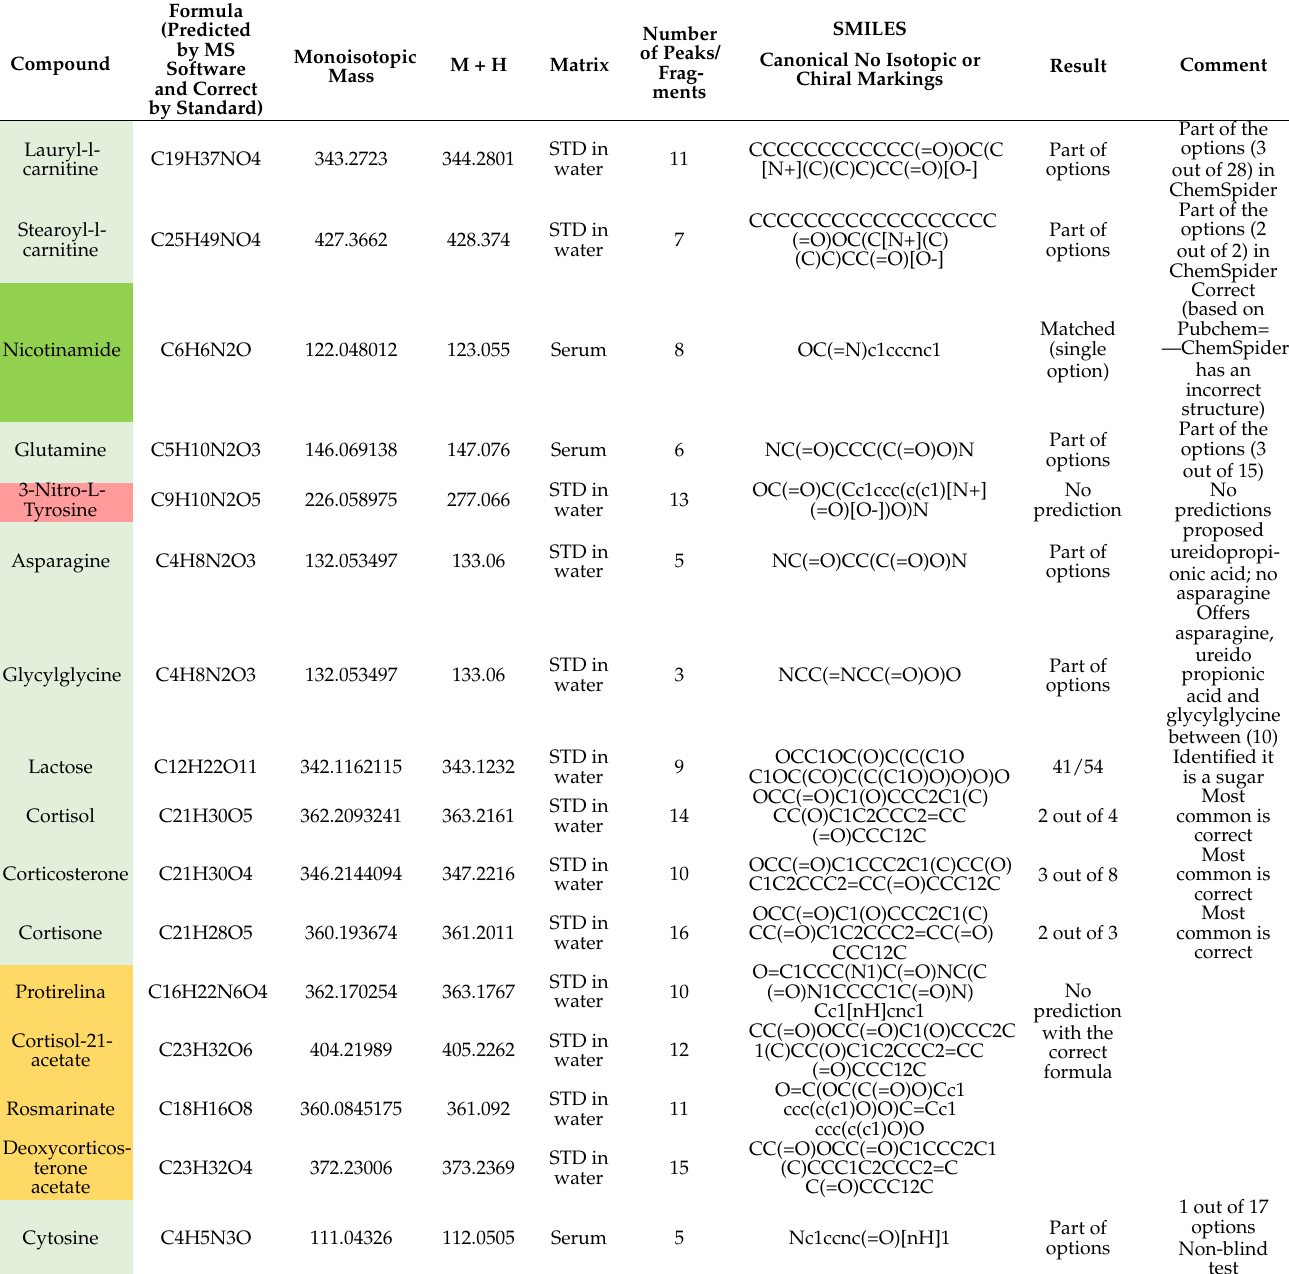
Table 2. Predictions by MassGenie of molecular structures from experimental positive electrospray mass spectra, Molecules were provided single-blind to MassGenie and the ranked outputs are recorded. 11 of the 16 molecules could be predicted. Colors reflect the precision of the results as described in the Result